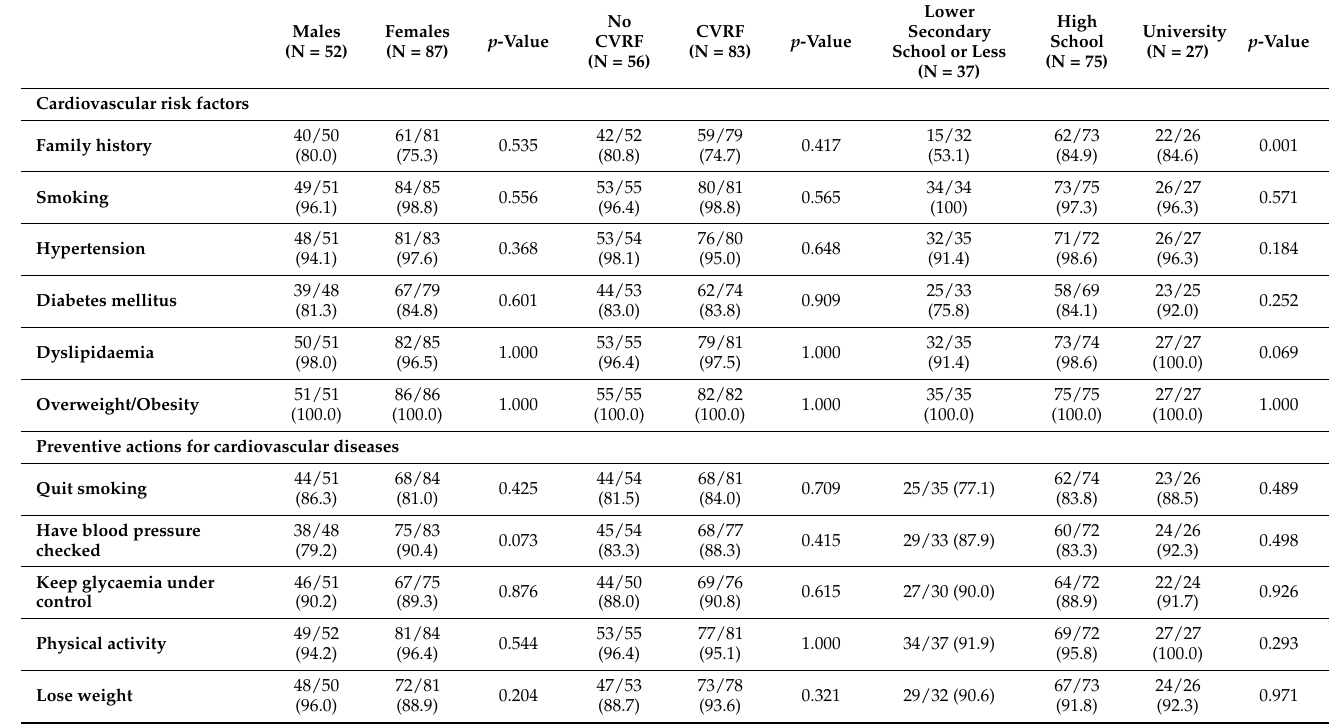
Table 3. Patient’s knowledge about main cardiovascular risk factors and preventive measures for cardiovascular diseases, according to gender, presence of CVRFs, and education